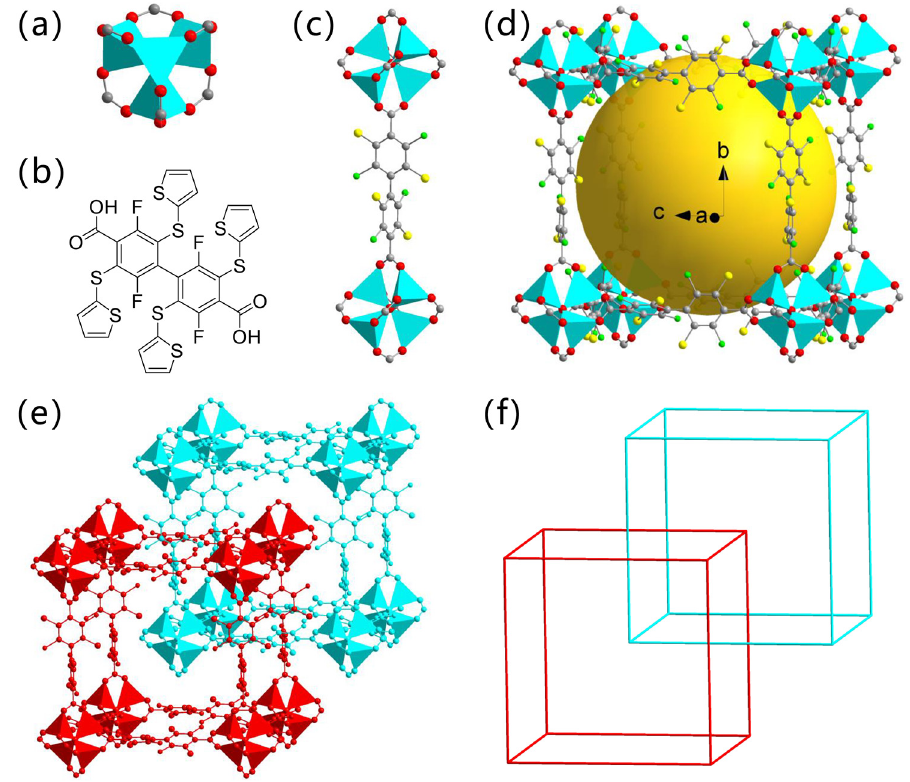
Figure 1. ( a ) Zn 4 O(COO) 6 cluster of ZnBPD-4F4TS . ( b ) Ligand H 2 BPD-4F4TS used in this work. ( c ) Coordination mode diagram of linker BPD-4F4TS 2 − . ( d ) A three-dimensional network diagram of ZnBPD-4F4TS . The ball is present to display the inner void filled with disordered pendent thiophene groups. ( e ) Two-fold interpenetrated framework of ZnBPD-4F4TS . ( f ) A simplified topology of ZnBPD-4F4TS . Hydrogen atoms are omitted for clarity and thiophene groups are absent because of their high disorder. Atom color: red, oxygen; gray, carbon; green, fluorine; yellow, sulfur; cyan, Zn 4 O polyhedron.